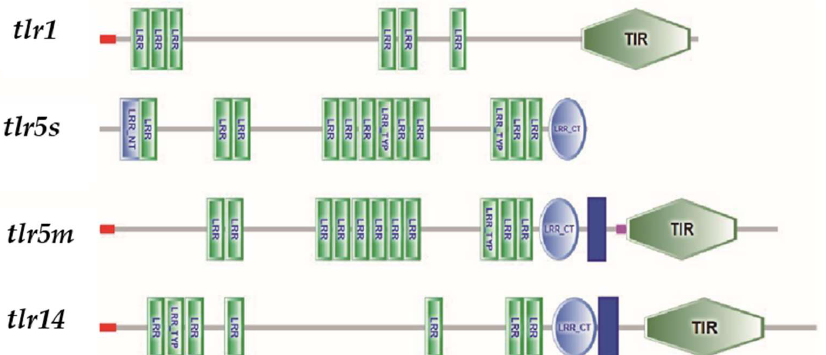
Figure 1. Structural characteristics of TLRs of swamp eel.: Signal peptide; LRR-NT; LRR; Transmembrane zone; Low complexity zone; LRR-CT; TIR. TLR, toll like receptor; LRR-NT, N-terminal leucine-rich repeat; LRR, leucine-rich repeat; LRR-CT, C-terminal leucine-rich repeat; TIR, Toll/interleukin-1 receptor domain.